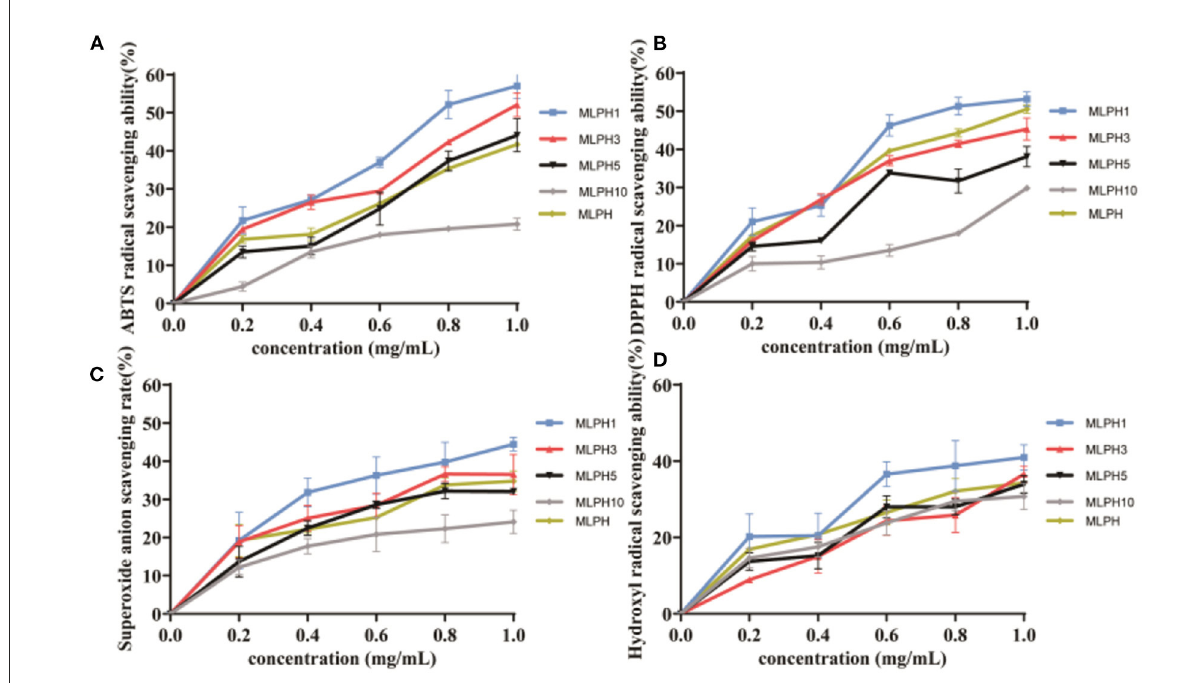
FIGURE1 Antioxidant activity of MLPH. (A) ABTS free radical scavenging ability; (B) DPPH free radical scavenging ability; (C) superoxide anion radical scavenging ability; (D) hydroxyl radical scavenging ability; MLPH1 is < 1 kDa M. oleifera leaves proteolytic, MLPH2 is 1 ∼ 3 kDa M. oleifera leaves hydrolysates, MLPH5 is 3 ∼ 5 kDa M. oleifera leaves proteolytic, MLPH10 is 5 ∼ 10 kDa M. oleifera leaves proteolytic. Data are expressed as mean ± SD from three independent experiments ( n =